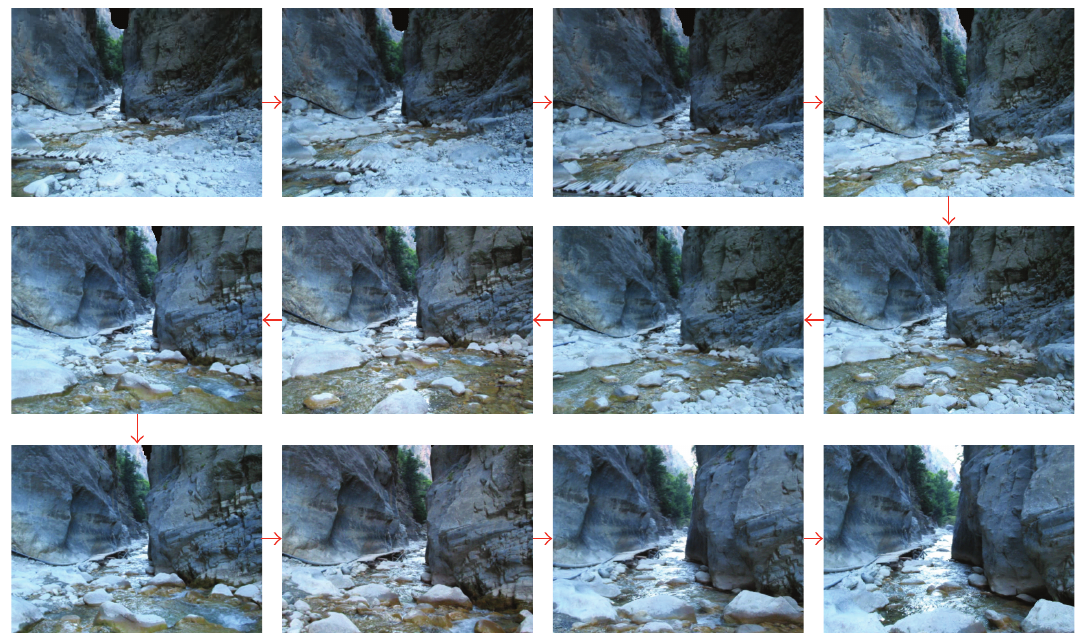
Figure 12: Some rendered views that are produced as the virtual camera traverses a path through the so-called “Iron Gates” area, which is the most famous part of the Samaria Gorge. In this case, the virtual camera passes through multiple morphable 3D models.